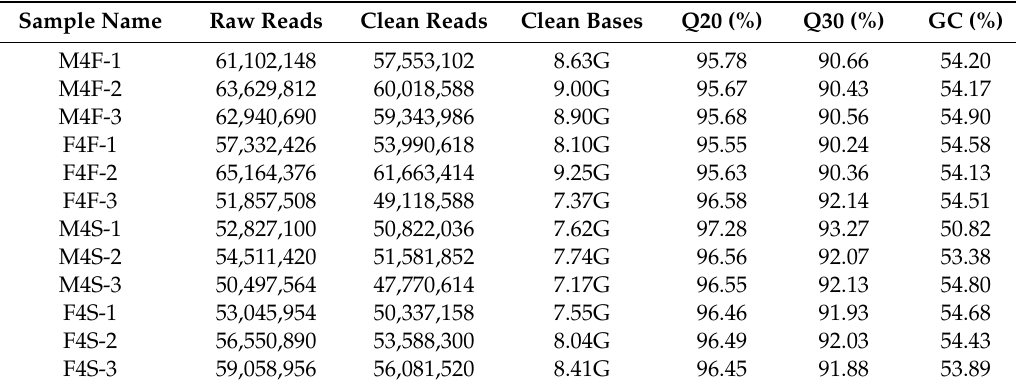
Table 3. Data quality from sequencing the four-week-old samples.